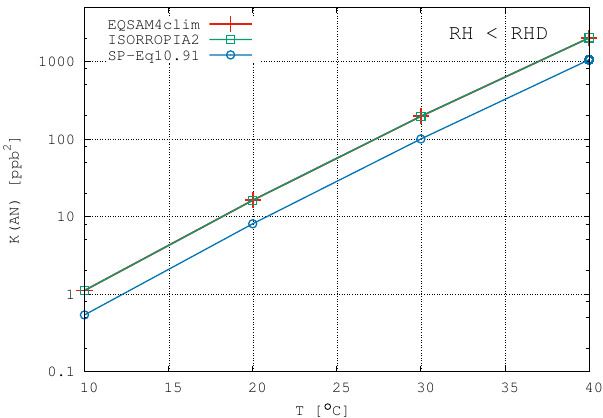
Figure 1. NH 4 NO 3 equilibrium dissociation constant as function of T at RH < RH(AN). Red crosses show the values of EQSAM4clim, green squares refer to ISORROPIA II and the blue circles show Eq. (10.91) of Seinfeld and Pandis (2006); see their Fig. 10.19.